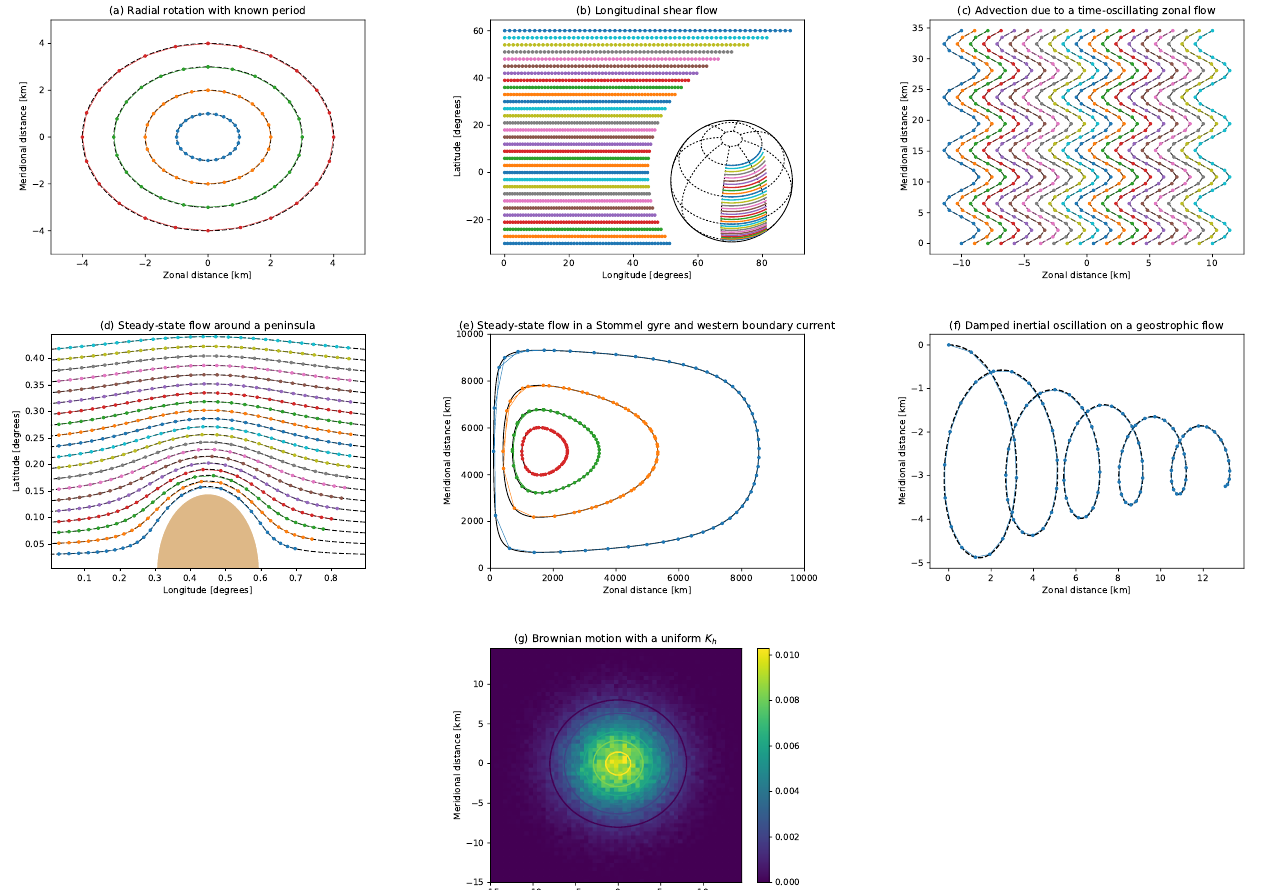
Figure 4. Evaluation of trajectory accuracy in Parcels v0.9, following the seven idealized and analytical test case described in Sect. 6 of Van Sebille et al. (2018): (a) radial rotation with known period; (b) longitudinal shear flow; (c) advection due to a time-oscillating zonal flow; (d) steady-state flow around a peninsula; (e) steady-state flow in a Stommel gyre and western boundary current; (f) damped inertial oscillation on a geostrophic flow; and (g) Brownian motion with a uniform K h . In the upper six panels, the coloured lines are the particle trajectories and the black dashed lines are the analytical solutions. In panel (g) , the colouring shows the density of particles, and the contours show the probability density function of the equivalent analytical solution (a two-dimensional